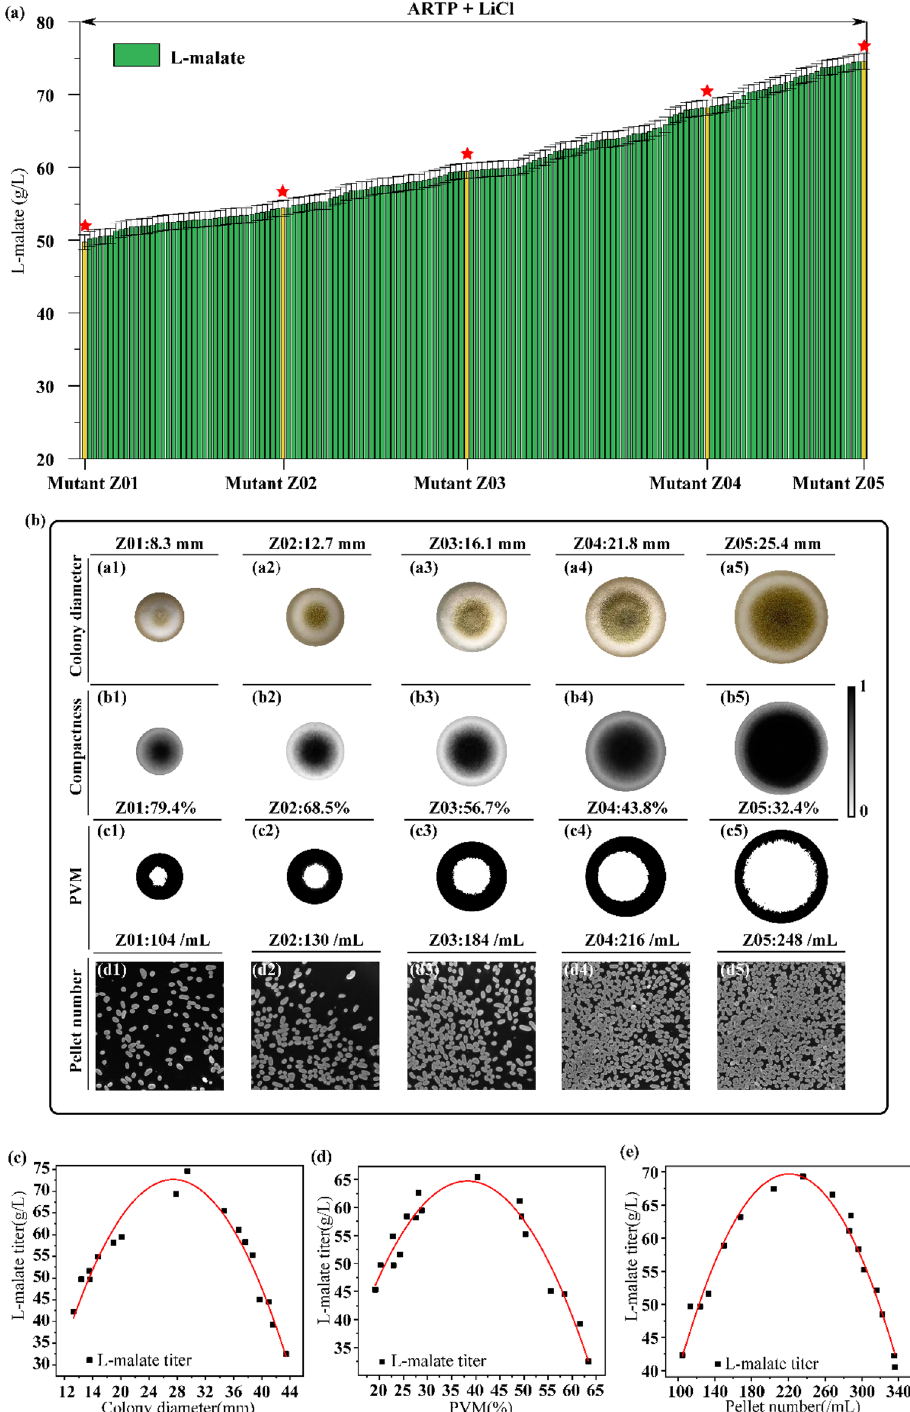
Fig. 1 Effect of the A. oryzae growth status on L-malate production. a The mutant library was constructed by ARTP irradiation and LiCl mutagenesis. b Images of the colonies (a1–a5), compactness (b1–b5), percentage of vegetative mycelia (PVM) of colonies(c1–c5) and pellet number (d1–d5) of the five mutants. c The relationship between the colony diameter and L-malate titer meet Y = − 0.15 X 2 + 7.06 X − 10.72 (cid:31) R 2 = 0.95 (cid:30) . d The relationship between PVM and L-malate titer meet Y = − 0.05 X 2 + 4.92 X − 53.89 (cid:31) R 2 = 0.94 (cid:30) . e The relationship between pellet number